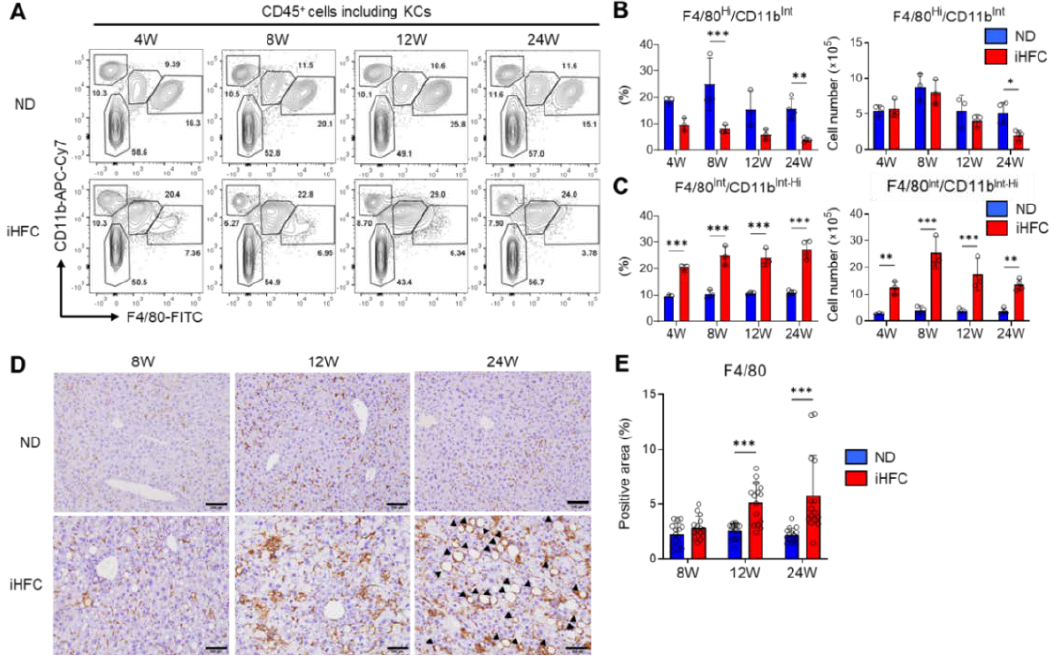
Figure 4. The iHFC diet accumulates F4/80 Int /CD11b Int-Hi recruited macrophages which constitute hCLS. ( A ) Representative flow cytometry data of F4/80 and CD11b expression on CD45 + non-parenchymal cells of the livers from TSNO mice on the ND or iHFC diet for the indicated time periods. ( B ) Percentage ( Left ) and cell number ( Right ) of F4/80 Hi /CD11b Int KCs were determined by flow cytometry analysis done in ( A ) ( n = 3 or 4 per group). ( C ) Percentage ( Left ) and cell number ( Right ) of F4/80 Int /CD11b Int-Hi recruited macrophages were determined by flow cytometry analysis done in ( A ) ( n = 3 or 4 per group). ( D ) Representative histological images of F4/80 immunostaining of the livers from TSNO mice on the ND or iHFC diet for the indicated time periods. Arrow heads depict hCLSs. Scale bars, 100 µ m. ( E ) Five locations were photographed per three sections per each group. Then, positive areas for F4/80 were measured at 15 locations per each group using ImageJ software, and the mean and SD were calculated. Data are shown as means ± SD. * p < 0.05, ** p < 0.01, *** p < 0.001. Statistical significance was evaluated by two-way ANOVA followed by post hoc Sidak test.